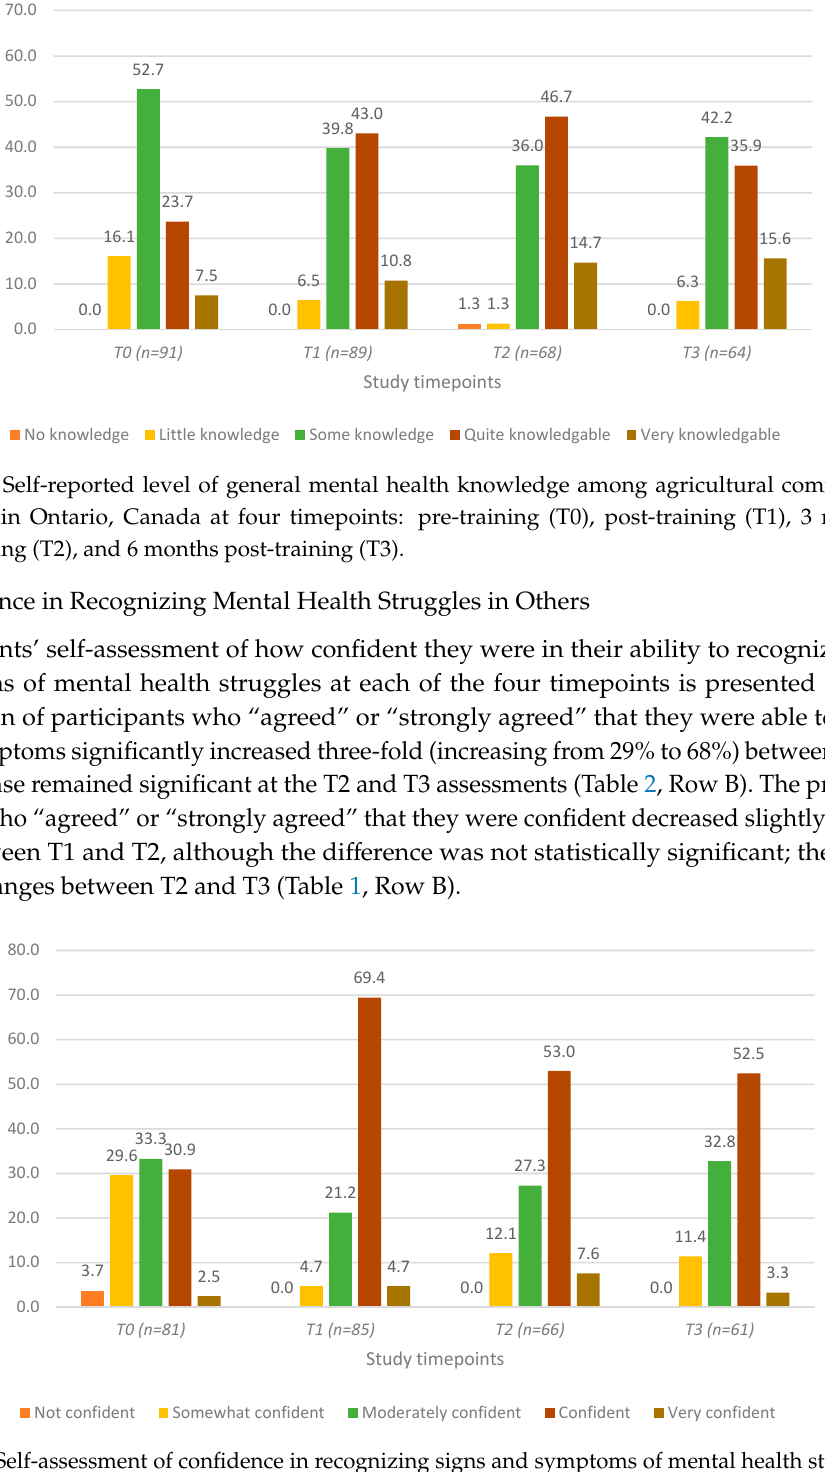
Figure 2. Self-assessment of confidence in recognizing signs and symptoms of mental health struggles among agricultural community members in Ontario, Canada at four timepoints: pre-training (T0), post-training (T1), 3 months post-training (T2), and 6 months post-training (T3).